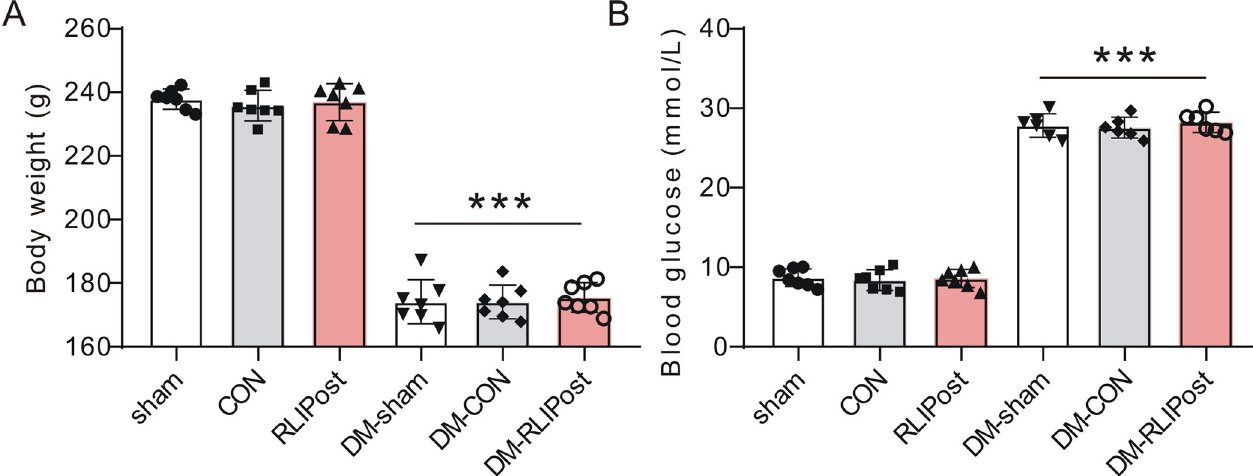
Fig 2. The effect of STZ on body weight and plasma glucose. A. The effect of STZ treatment on body weight. Values are mean ± SD. ��� P < 0.001, compared with nondiabetic rats. Sham: sham-operated, CON: control, RLIPost: remote liver ischemia postconditioning. DM: STZ-induced diabetes. n = 7 per group. B. The effect of STZ treatment on plasma glucose. Values are mean ± SD. ��� P < 0.001, compared with nondiabetic rats. n = 6–7 per group.